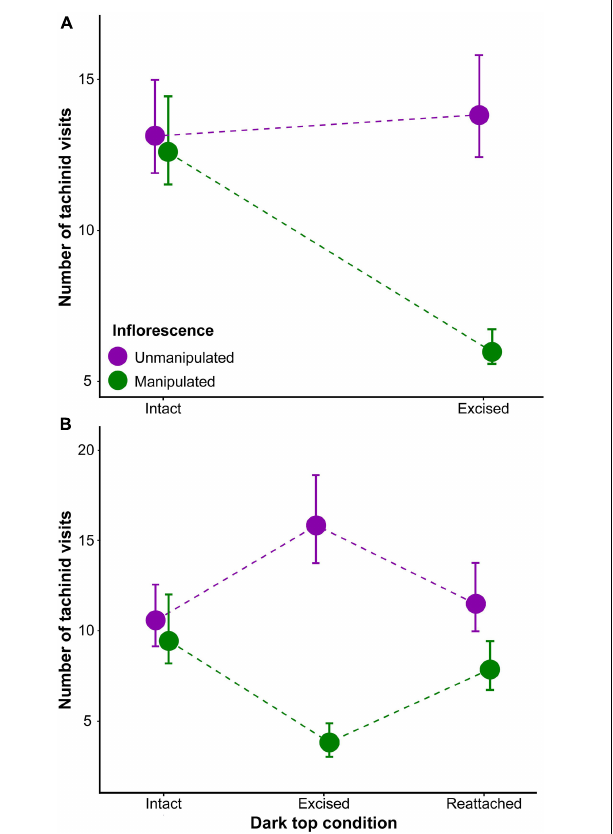
FIGURE 10 | Attractiveness of inflorescence pairs of Neotinea ustulata varieties to pollinators: (A) Tachina aff. fera visits to var. ustulata inflorescences with and without the dark top excised from one of them. (B) Nowickia ferox visits to var. aestivalis inflorescences with, without and reattached dark top. Note the visits to the inflorescence decrease when dark top is visually absent to pollinators. Back-transformed means and standard errors are